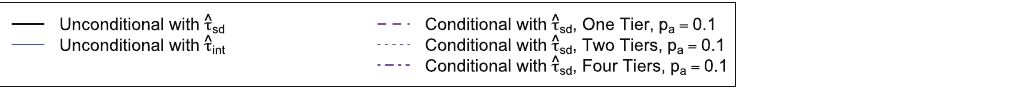
Figure 11: Average rejection rate of the unconditional randomization tests using ̂ τ sd and ̂ τ int as well as our conditional random- ization test when the potential outcomes were generated from the Moderate Correlation model (24) or the No Correlation model